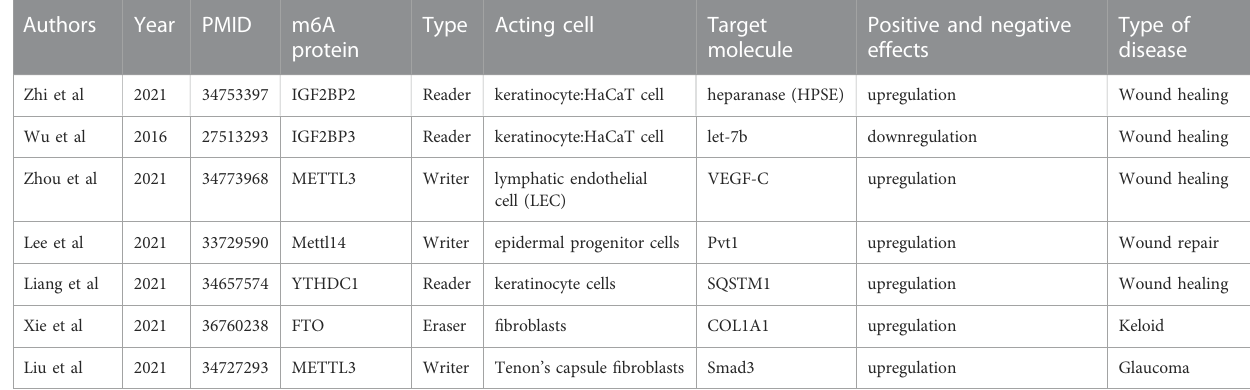
TABLE 1 Current research progresses of m6A methylation in wound healing, hypertrophic scars, and keloids.